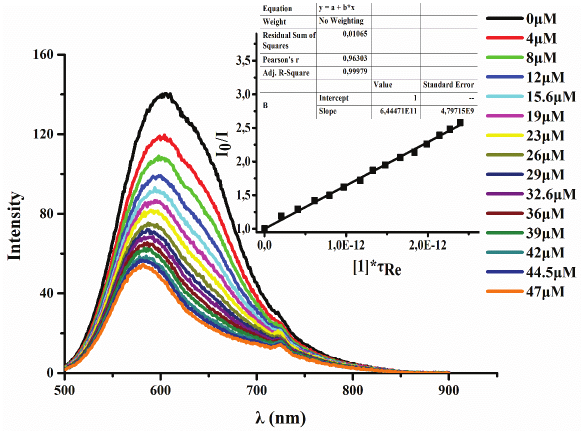
Figure 13: Emission spectra of [ReBr(CO) in acetone, Inset: K τ =51 ns (25 o C ). re